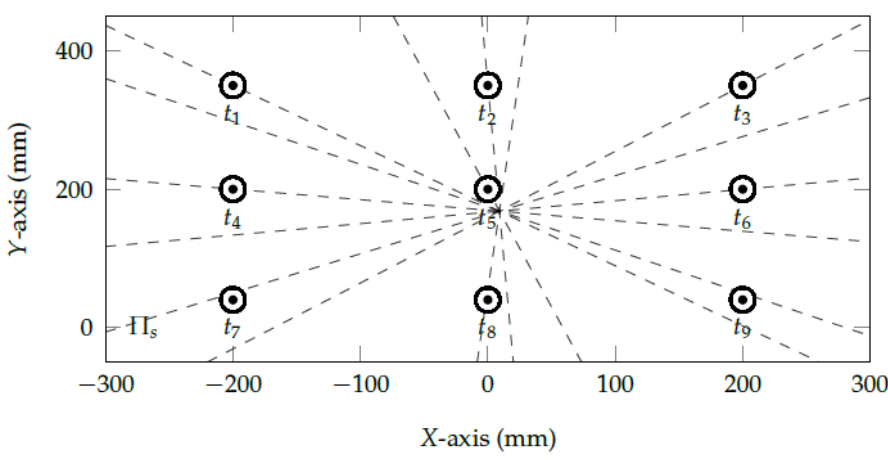
Figure 5. The epipolar geometry between the normalized space Π n and the viewed space Π s . After normalizing the eye-tracking data using a second-order polynomial, the epipole represents the eye-camera location in relation to Π s which is very close to the actual center of the viewed